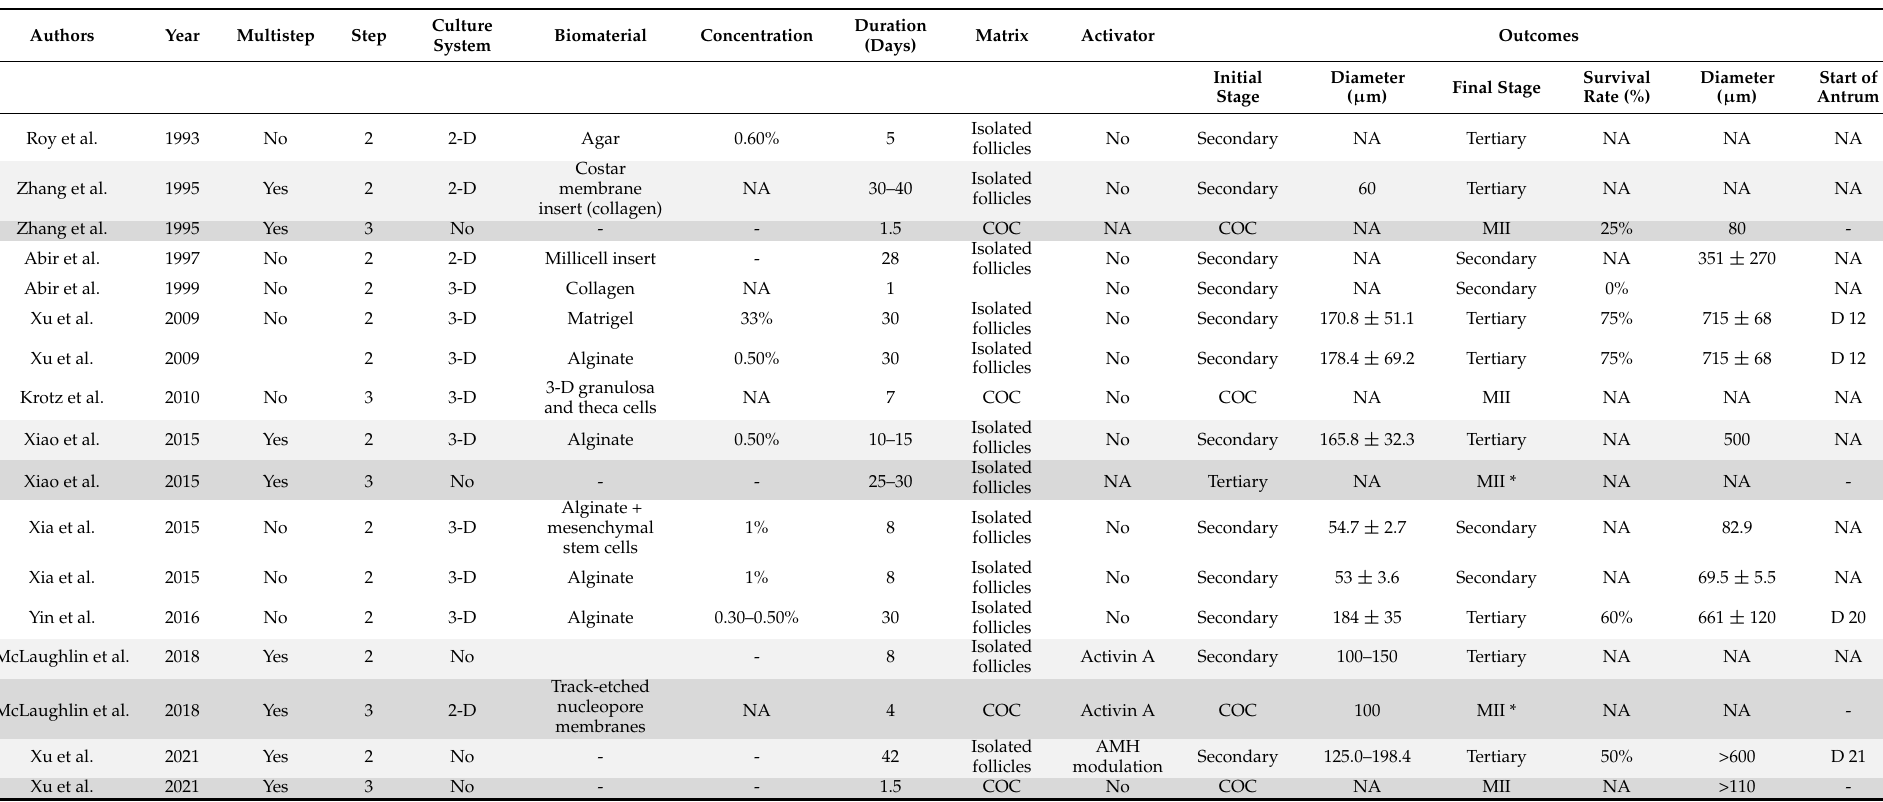
Table 5. Studies reporting human in vitro folliculogenesis from the secondary to the antral follicle stage (step 2) and then from the cumulus-oocyte complex to the metaphase II oocyte (step